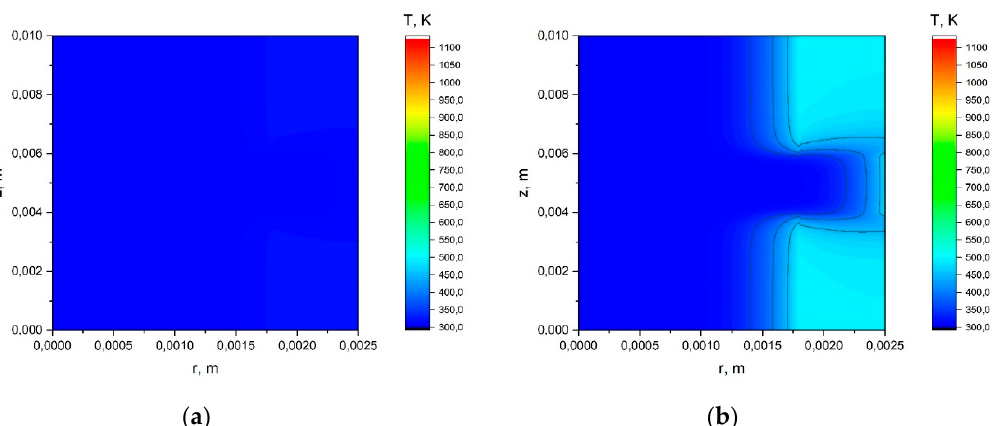
Figure A20. Temperature distribution in the stem of a herbaceous plant: R = 0.0025 m, t = 0.5 s, q = 3 kW/m 2 ( a ); R = 0.0025 m, t = 0.5 s, q = 30 kW/m 2 ( b ).